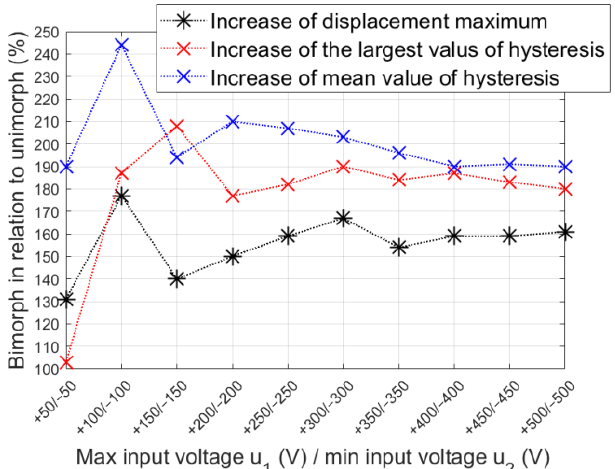
Figure 12. Comparison of increases of maximum displacements of the actuator beam tip, maximum hystereses, and mean values of hysteresis between the bimorph and unimorph. The use of the two-input system led to an increase in actuator tip displacement by an average of 55.5% compared to the single-input system, with maximum hystereses increasing by an average of 78.2% and mean hystereses increasing by 101%. The last element of the analysis was to compare the hystereses of the bimorph and unimorph in the range of characteristic input voltages for these hystereses. According